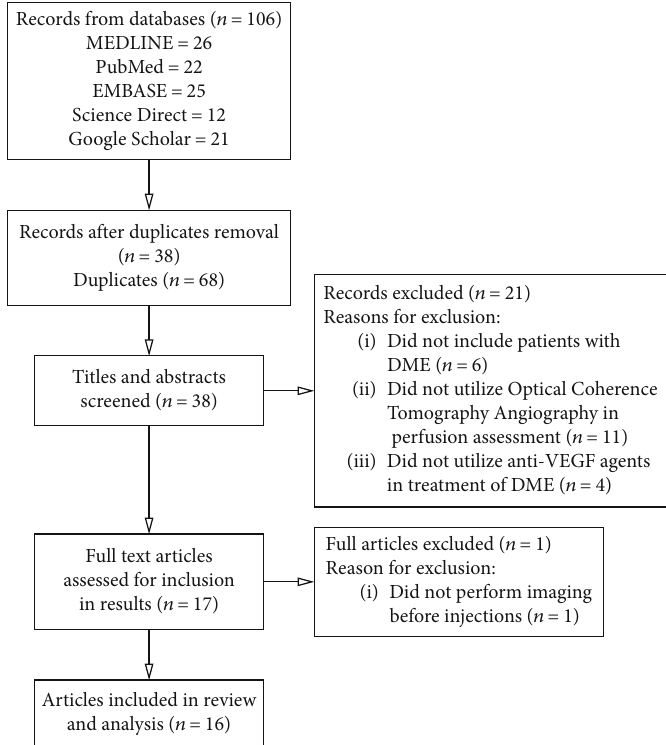
Figure 3: Flow diagram showing search results and reasons for exclusion of